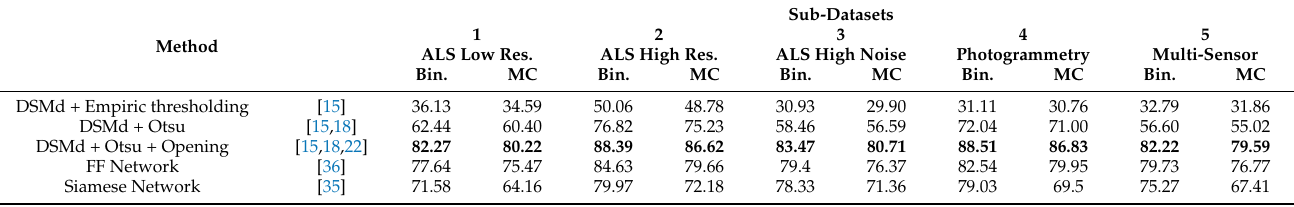
Figure 8. Results at the 2D pixel level for sub-dataset 2 (ALS High resolution). ( a , b ) DSMs with their elevations in meters and ( c ) ground truth (GT) with the following color code: purple for unchanged parts, blue for newly built parts and yellow for demolished parts. Results of DSMd with empirical thresholding ( d ), thresholds from the Otsu algorithm ( e ) and post-processing with an opening filter ( f ). Respective errors maps ( g – i ) highlight the differences (in red) from the ground truth. Table 3. Results of different methods on all sub-datasets at the 2D patch level. Means of IoU over classes of change are given (%). Bin. stands for binary classification results, MC for multi-class classification results and Res. for resolution. For each types of results best values are shown in